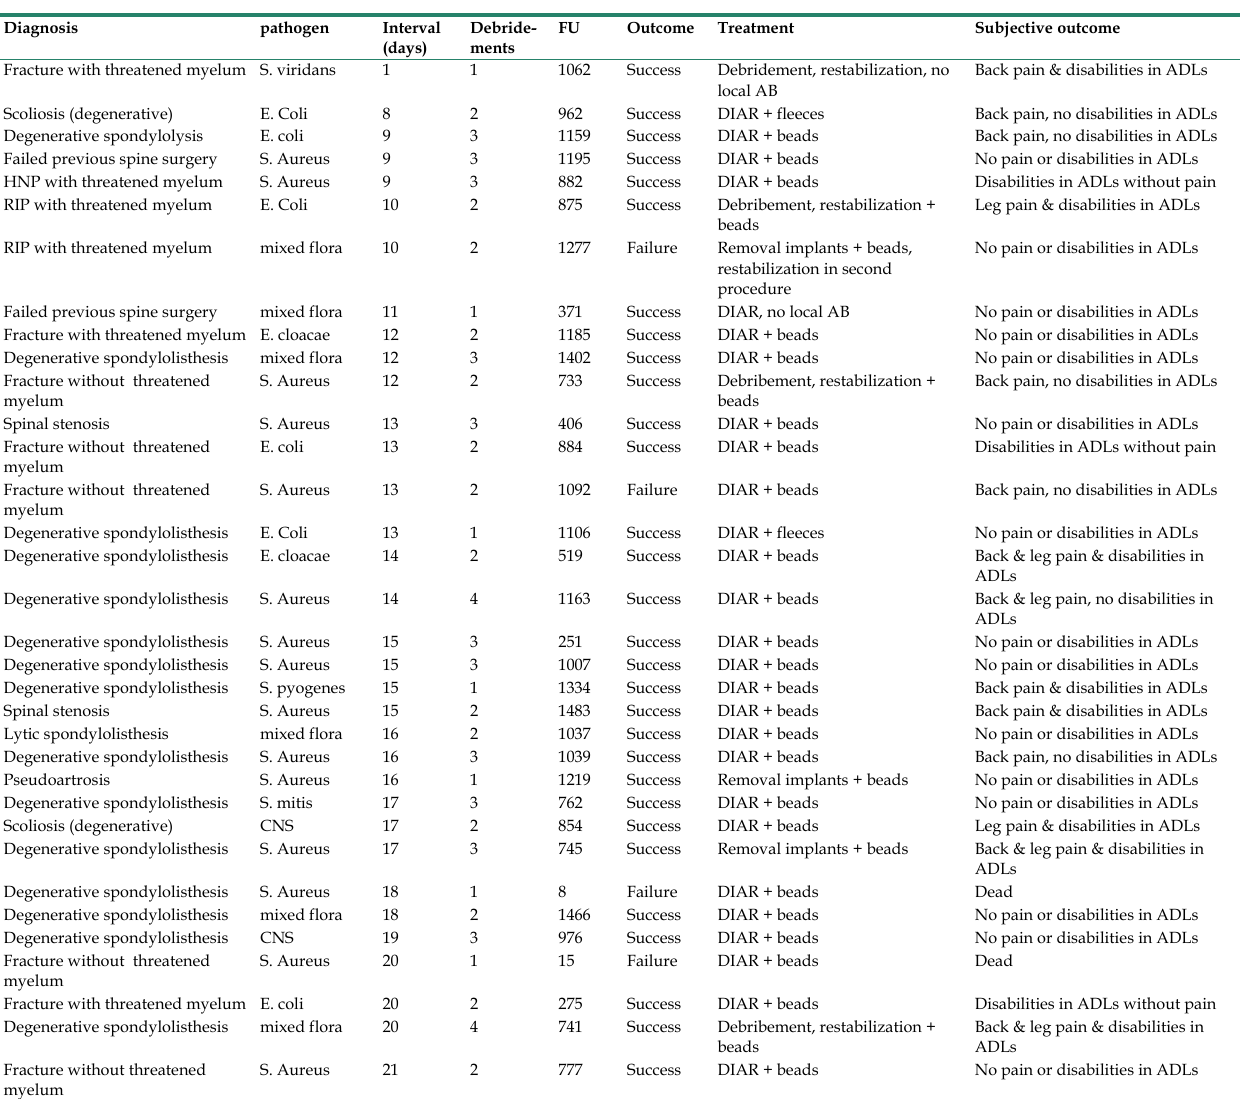
Debride- (days) ments